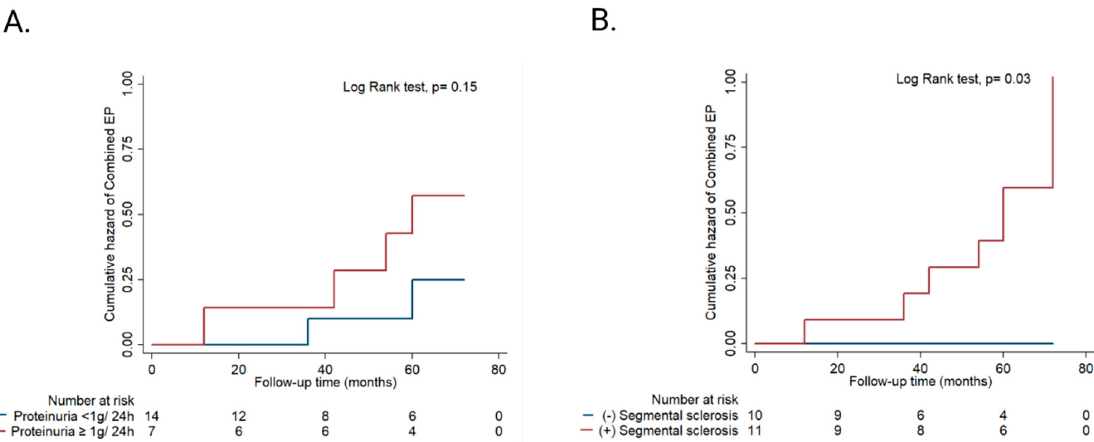
Figure 4. Cumulative hazard of the combined endpoint (EP) according to baseline: ( A ) Proteinuria ≥ 1 g/24 h; ( B ) segmental